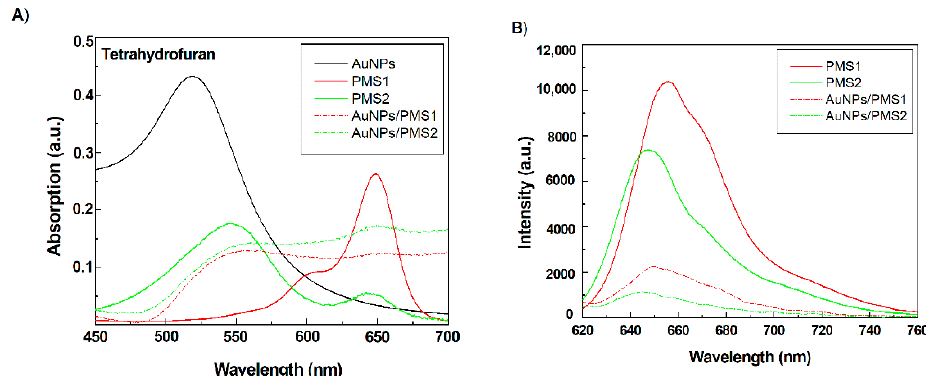
Figure 2. UV–Vis ( A ) and fluorescence ( λ ex = 590 nm, ( B ) spectra of a free (PMS, 1 μ g ml –1 ) and immobilized (AuNPs/PMS) receptor recorded in tetrahydrofuran. For comparison, there is UV–Vis spectrum of the freshly prepared AuNPs. The fluorescence spectrum of AuNPs showed no signal.